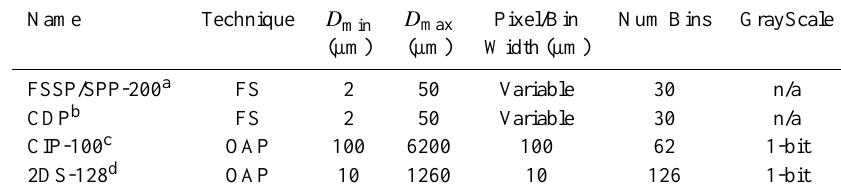
Table 2. Wing pylon mounted cloud probes on the FAAM BAe146 aircraft on 18 February 2009. Name